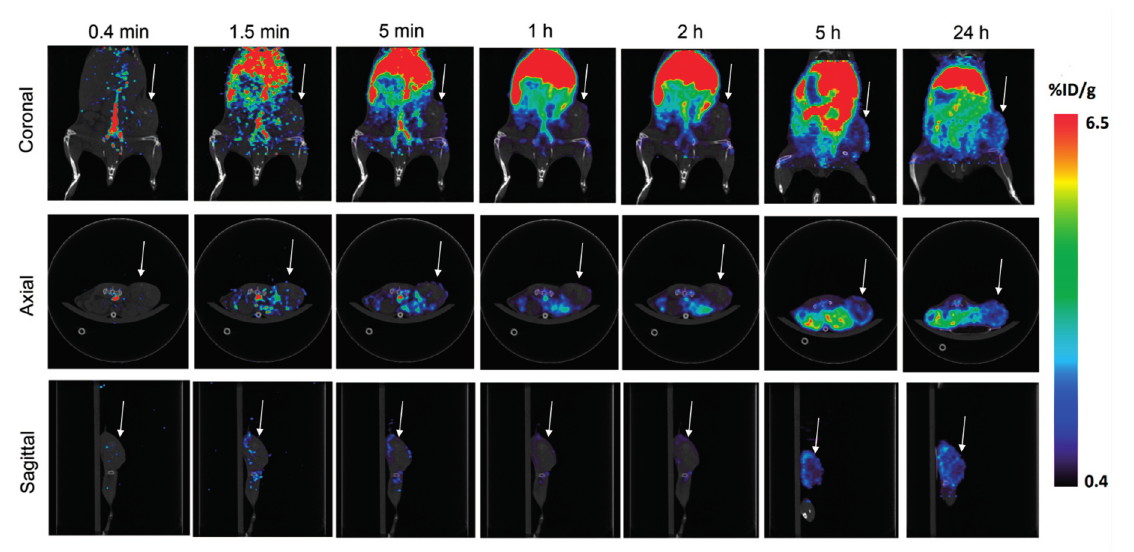
Figure 6. PET/CT imaging (3 orientations) of the tumor-bearing mouse following systemic nanoprobe injection. Images were obtained at 0.4, 1.5, 5 min, 1, 2, 5 and 24 h post injection, respectively. Tumor is shown under white arrow. High nanoprobe uptake in liver can be seen 1.5 min after IV injection through tail vein. Nanoprobes accumulate in tumor gradually within 24 h primarily in the tumor